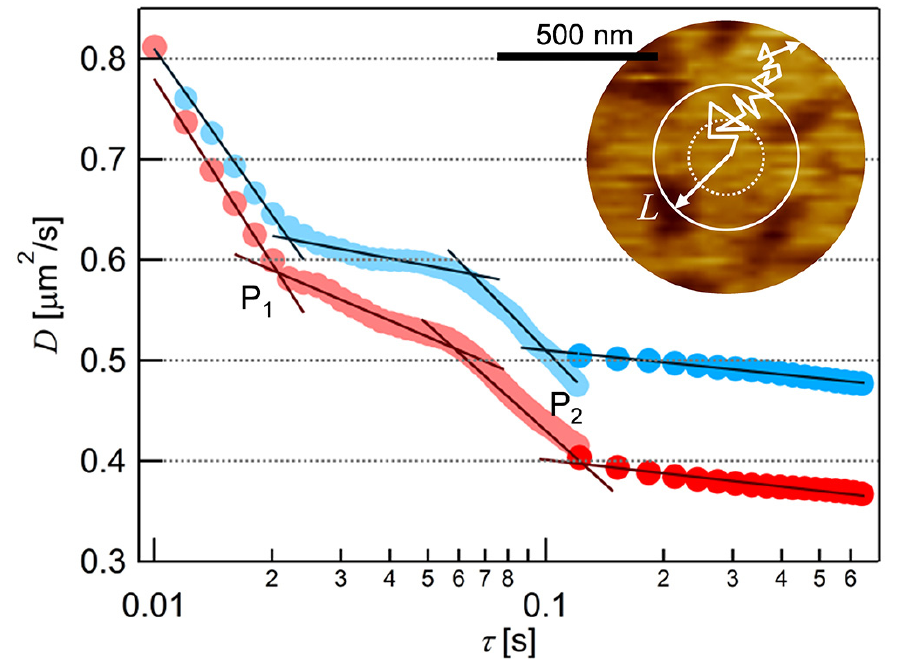
Figure 4. The dependence of diffusion coefficient ( D ) on time interval ( τ ) obtained from the analyses of the average MSD- τ plots of BODIPY-HPC (the blue plot) and DiI-C18 (the red plot) in PI+PC-SLB. The two infection points, P 1 = ( τ 1 , D 1 ) and P 2 = ( τ 2 , D 2 ), were obtained as the intersection of the extrapolated fitting lines (black lines) at the downward and flat regions of the D - τ plot. Inset: Schematic illustration of the diffusion behavior of a fluorescent probe superimposed on the AFM topography of the PI+PC-SLB.